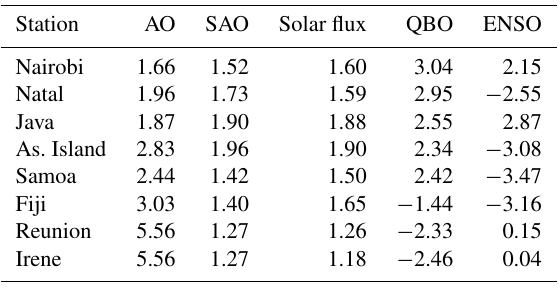
Table 5. Response values of the chosen proxies (annual cycle, semi- annual cycle, solar flux, QBO and ENSO) to total ozone variability for individual sites as obtained by the Trend-Run model. The re- sponse is given in percent by unit of the normalized proxy.